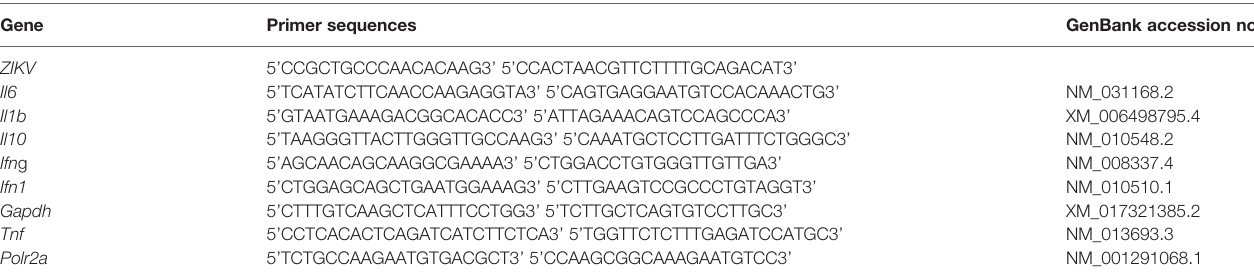
TABLE 1 | Primer sequences for the real-time PCR